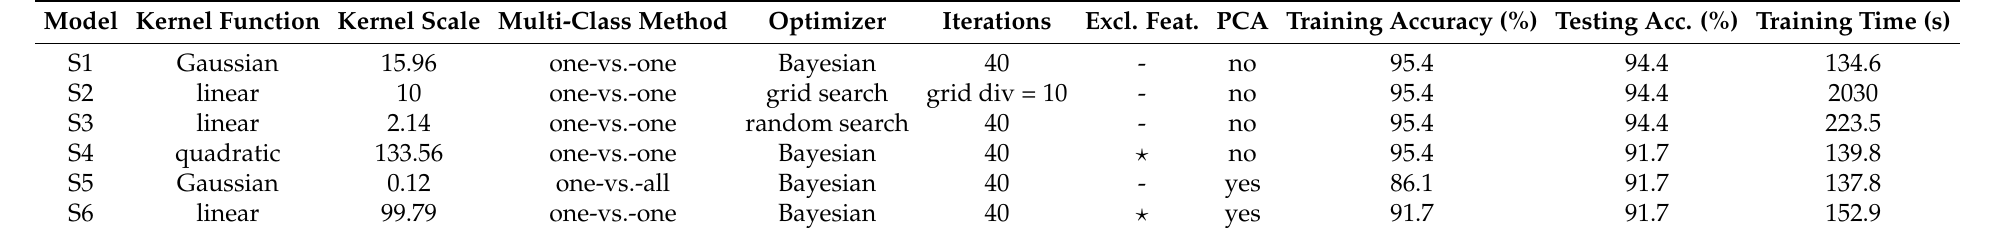
Table 4. Features of the SVM models, and relevant accuracies achieved. Excl. feat. = excluded features ( (cid:63) = top/bottom geometry, diagrid total length, maximum normal force).